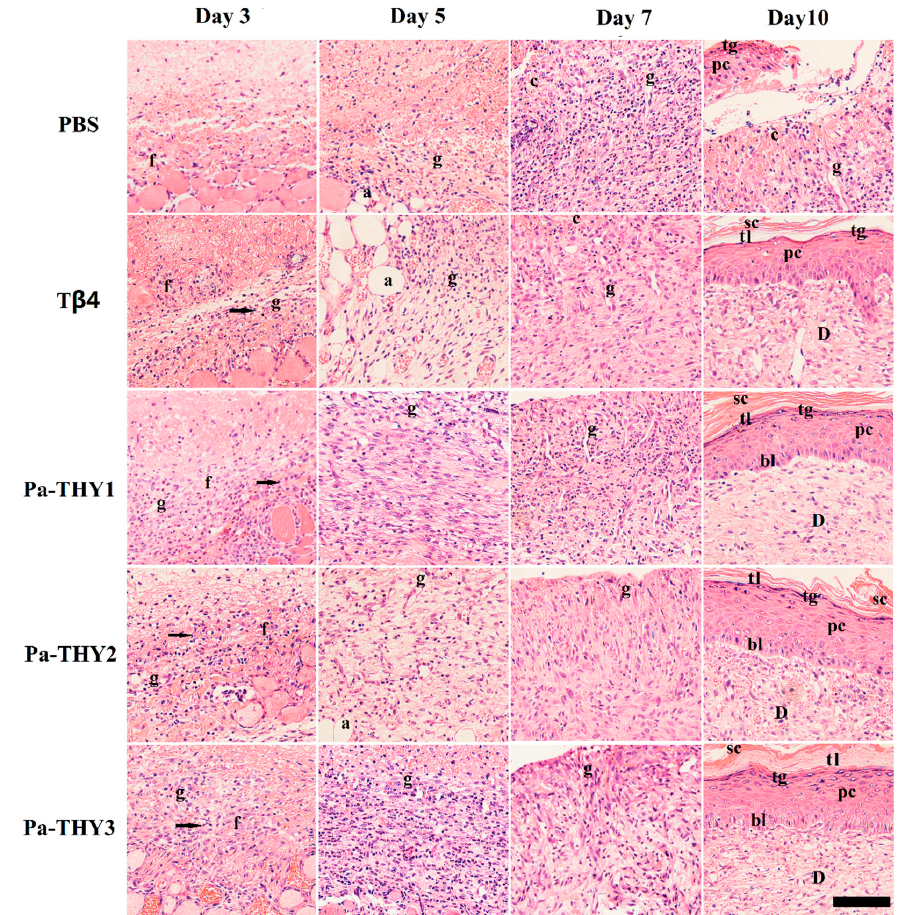
Figure 6. The H&E (hematoxylin-eosin) staining of dermal tissues treated with T β 4 and Pa-THYs proteins. a: adipose tissue; c: connective tissue; f: fibroblasts; g: granulation tissue; sc: stratumcorneum; tl: transparent layer; tg: granular layer; pc: prickle cell layer; bl: basal layer; D: dermis; monocytes: marked by black arrowhead (Scale bar = 100 μ m, ×200).